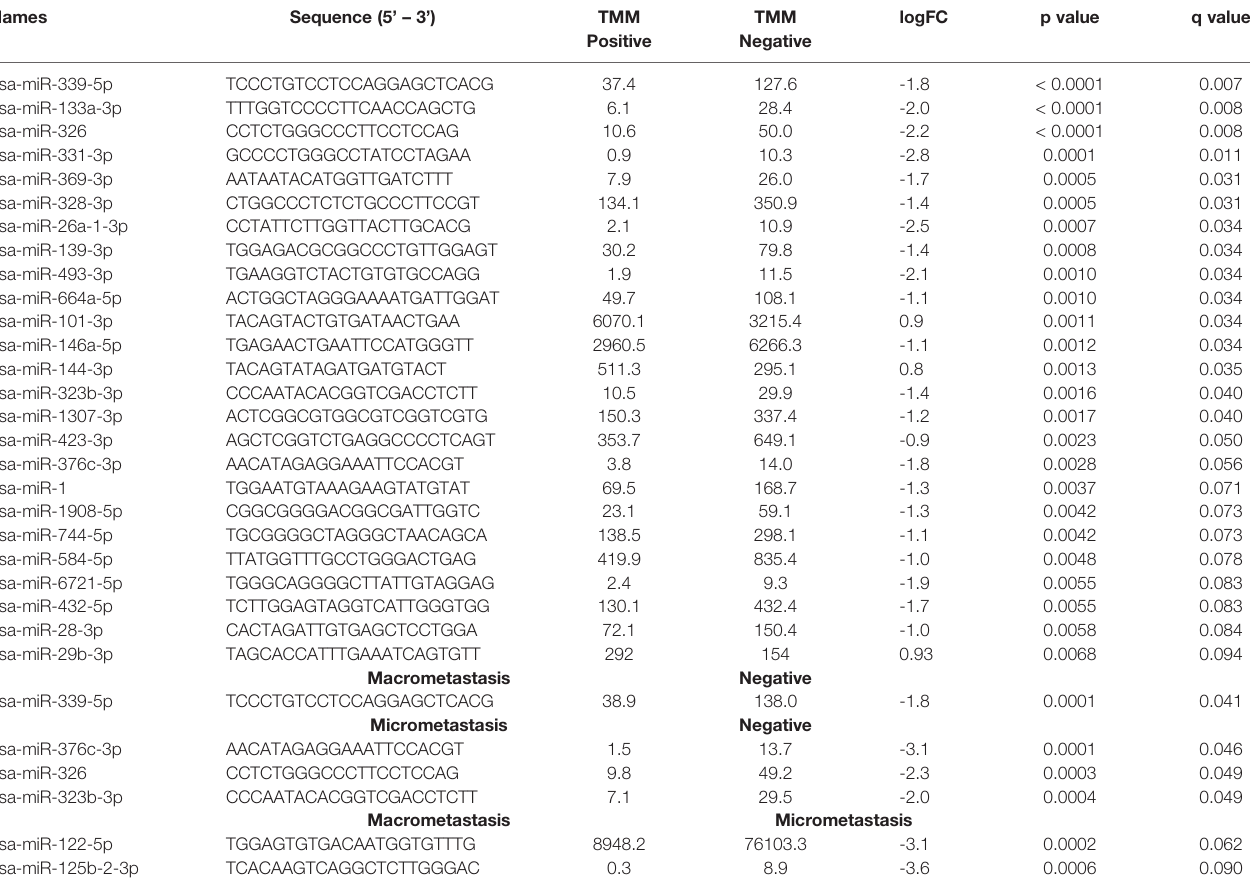
TABLE 2 | Differentially expressed